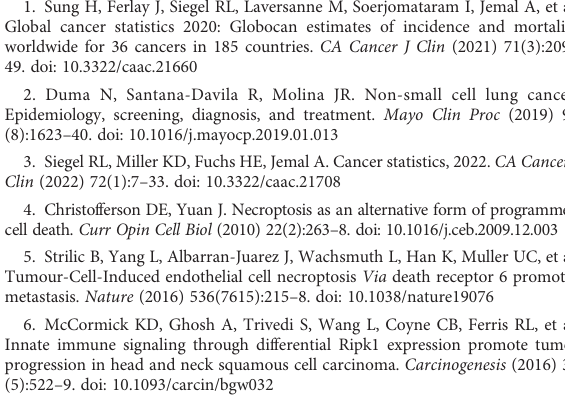
SUPPLEMENTARY FIGURE 4 Cell annotation in single-cell RNA-seq analysis and cell communication landscape of NecroLRS-associated subclusters. (A) Expression of key cell type markers in each cell type after annotation. (B) The landscape of incoming and outcoming interaction strength across each cell cluster. (C, D) Strength of cell communication among NecroLRS-Low and NecroLRS-High